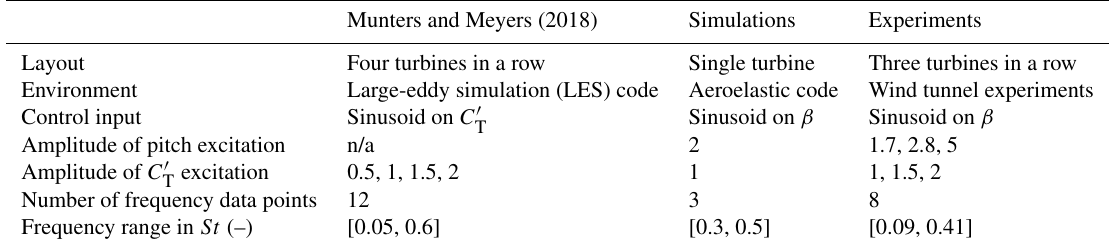
Table 1. Differences between the approach in Munters and Meyers (2018) and both the simulations and wind tunnel experiments presented in this paper. The number of experiments executed here is slightly lower. As a result, choices are made with regards to the excitation amplitudes and frequencies that have been investigated.